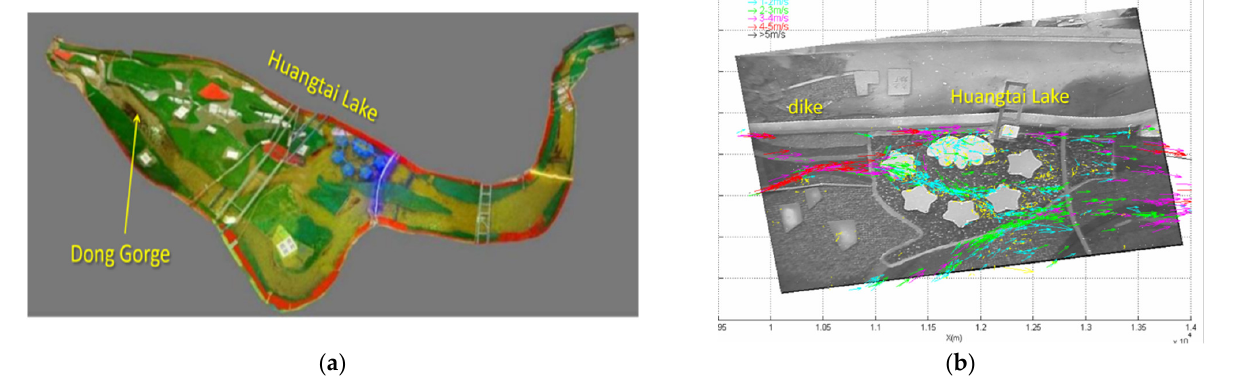
Figure 6. Flood field after implementation of the regulations along the Luanhe River for the design flood. ( a ) The flood field after implementation of the regulations across the whole river (Case S2). ( b ) Local velocity field of the artificial lake (Case S2).